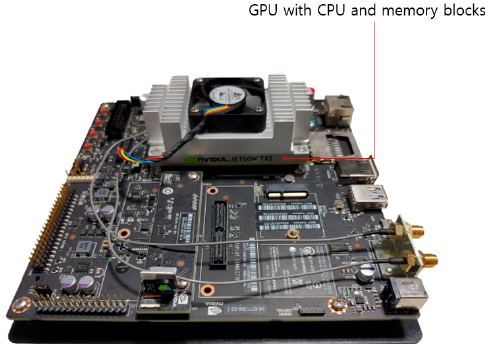
Figure 26. Jetson TX2 embedded system.